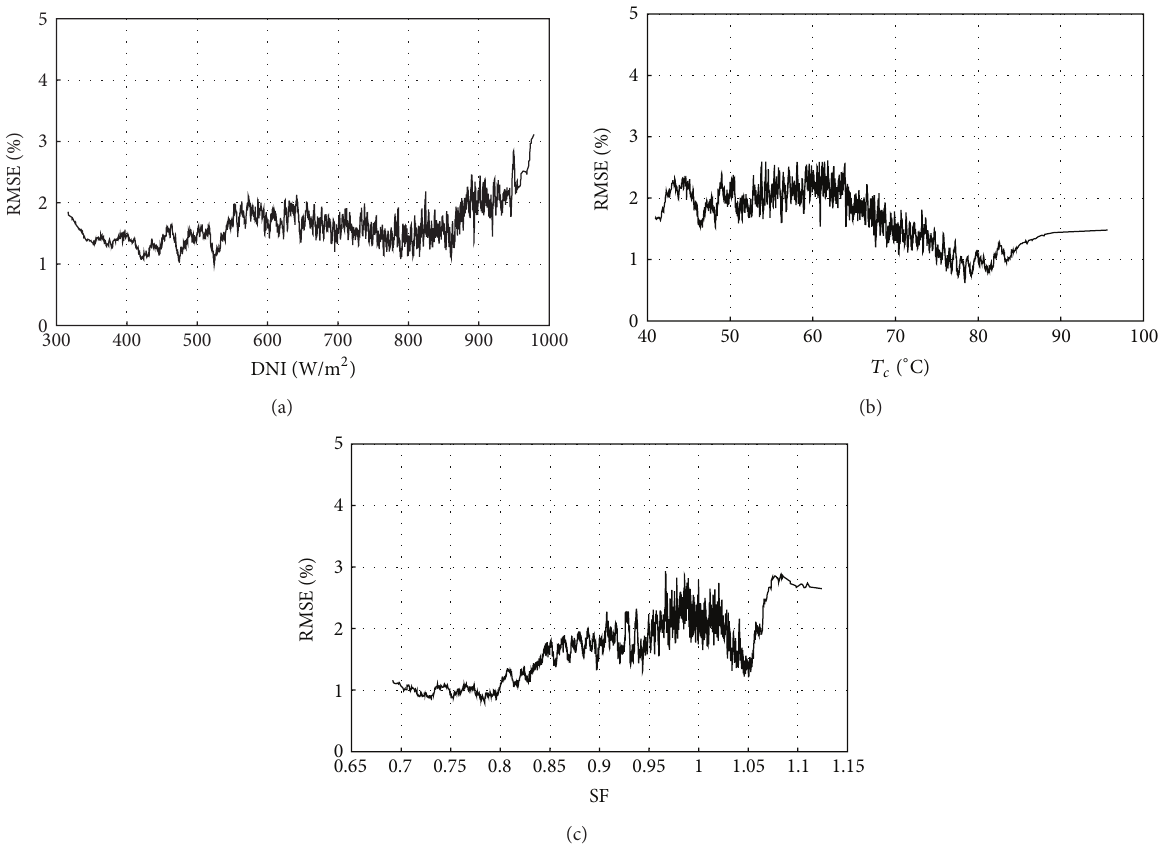
Figure 6: Root mean square error (RMSE) for different DNI, T 𝑐 , and SF levels for the proposed model for the HCPV considered.